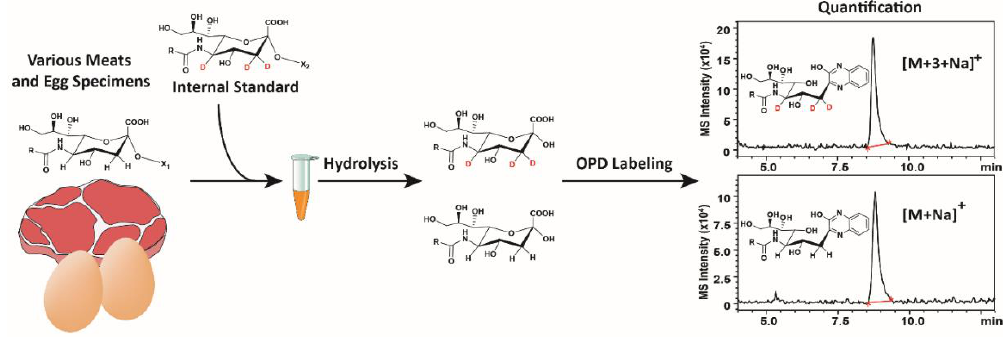
Figure 3. Overview of analyzing the sialic acid concentrations in meat and egg samples using d 3 -sialosides 9a and 9b as internal standards.